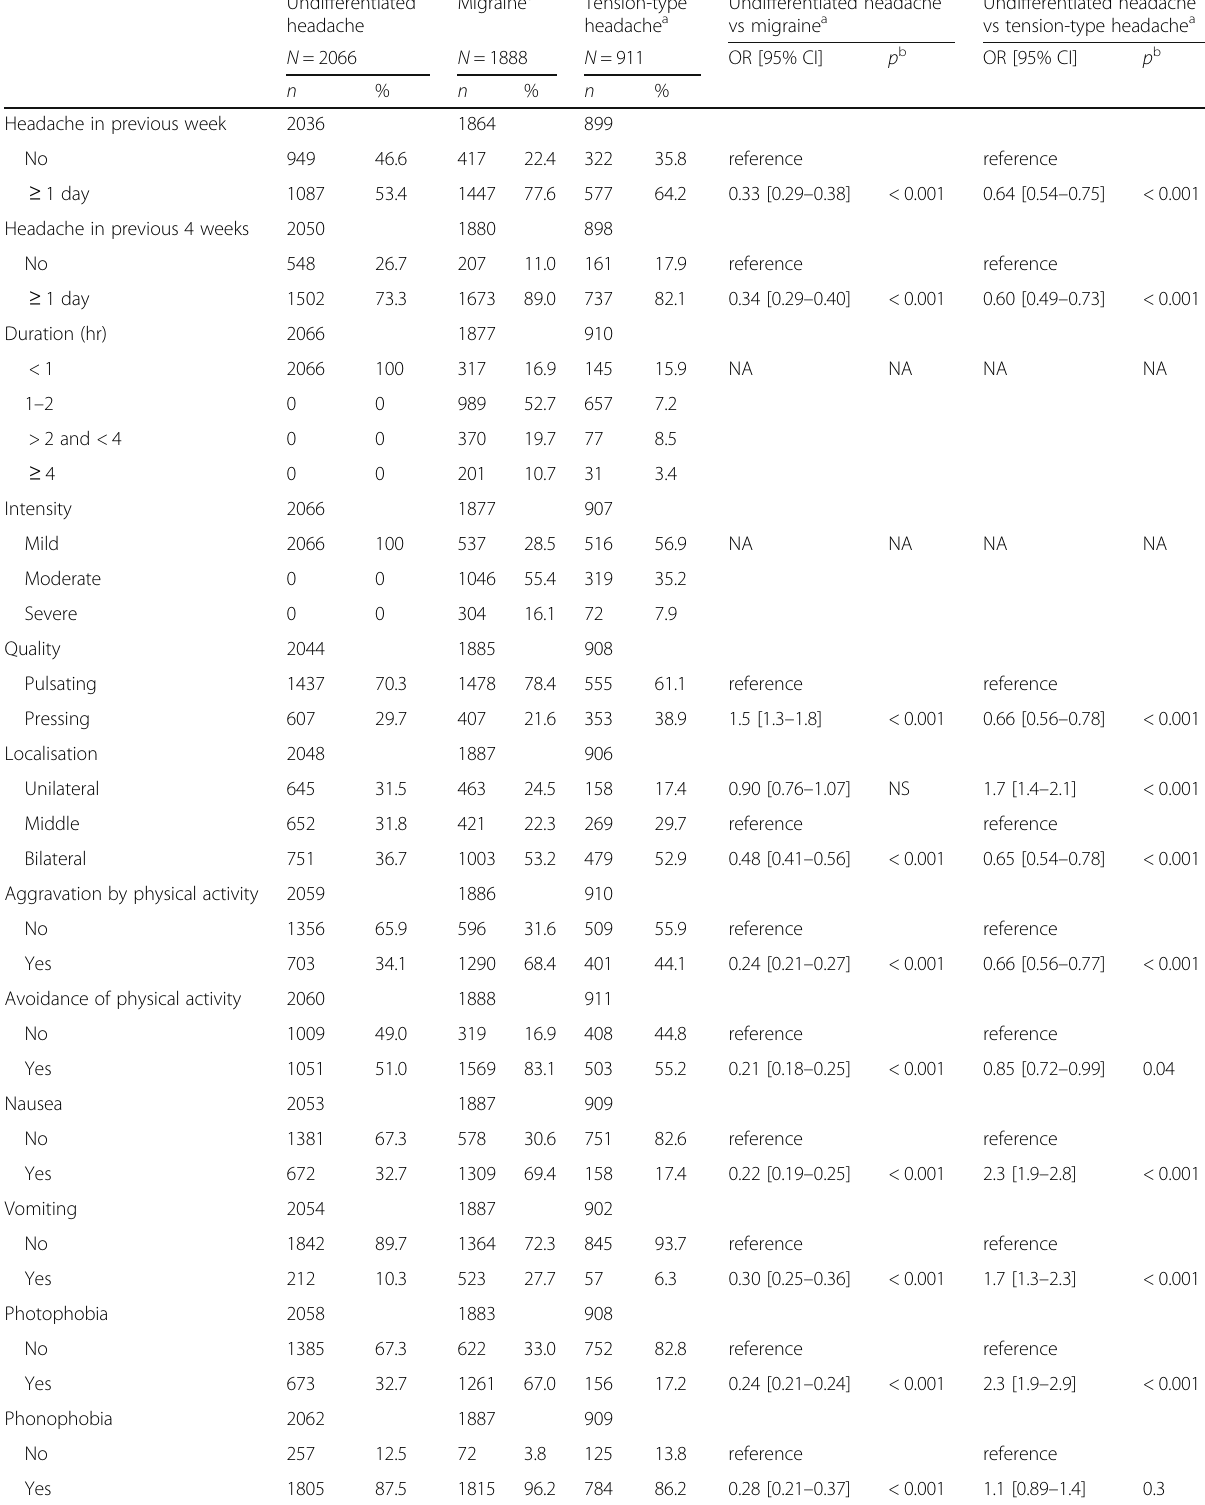
Table 1 Headache features in undifferentiated headache, migraine and tension-type